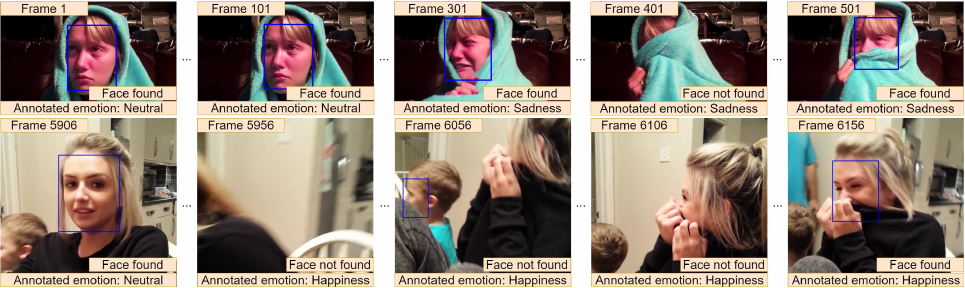
Figure 3. The example frames of two videos in the AffWild2 dataset, which demonstrate such challenges as pose variations and various